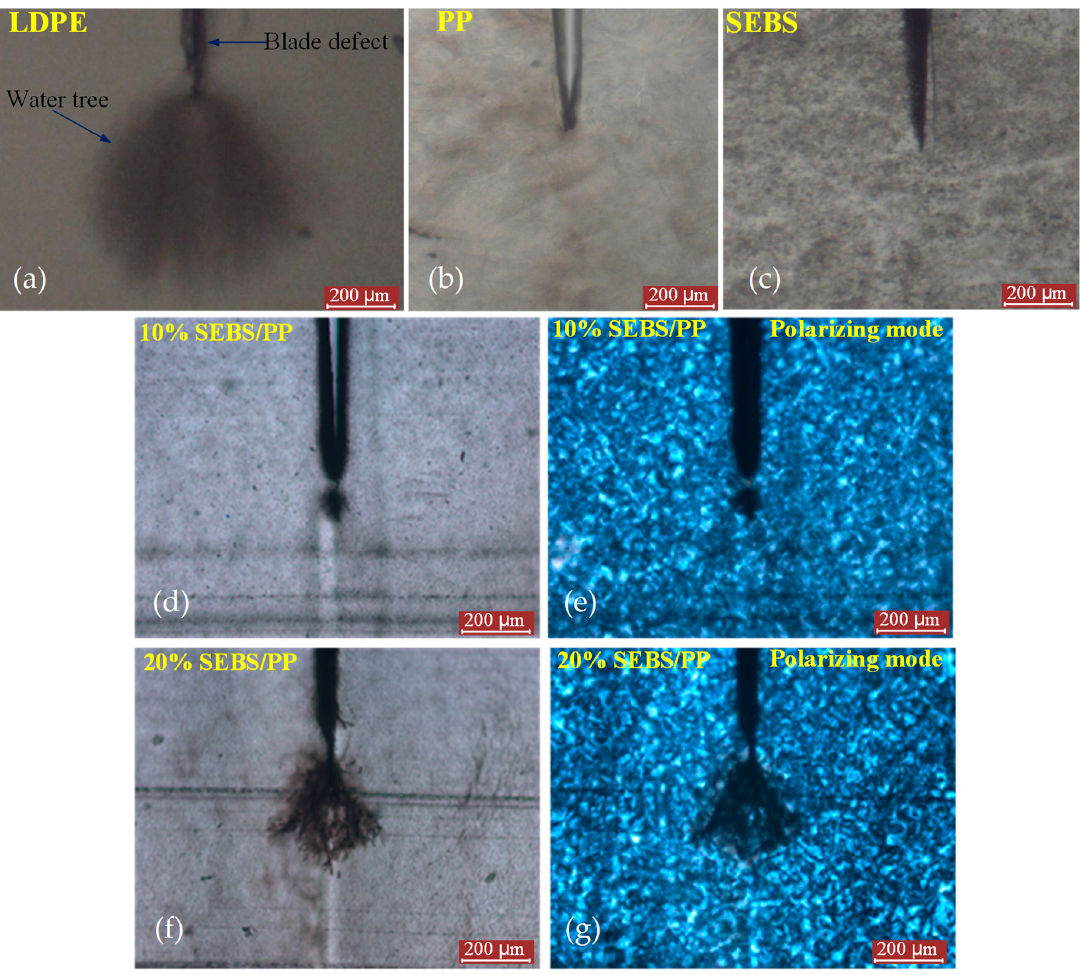
Figure 1. The water-tree morphology photographs of ( a ) low-density polyethylene (LDPE), ( b ) polypropylene (PP), ( c ) styrene-ethylene/butylene-styrene triblock copolymer (SEBS), ( d – g ) SEBS/PP composites observed with the optical microscope in normal mode ( d and f ) and polarizing mode ( e and g ).